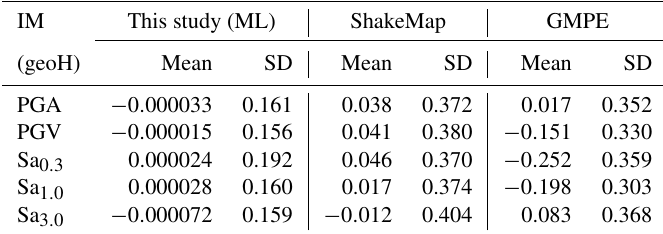
Table 3. Referring to the training dataset (15779 data points for each IM), comparison of mean and standard deviation values of the residuals’ distributions obtained in this study and those reported by other works (geoH stays for the geometric mean of the horizontal components). IM This study (ML) ShakeMap GMPE (geoH) Mean SD Mean